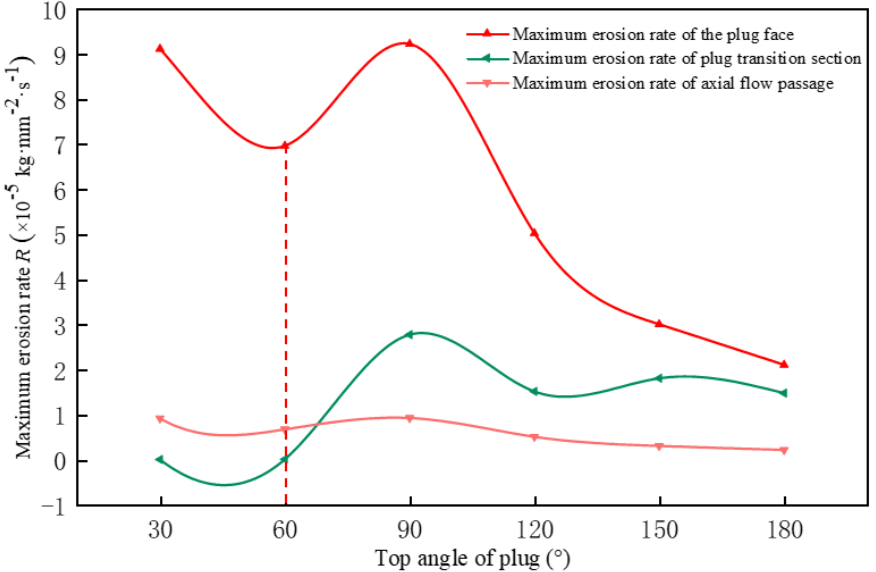
Figure 13. Maximum erosion rate changes with plug angle.